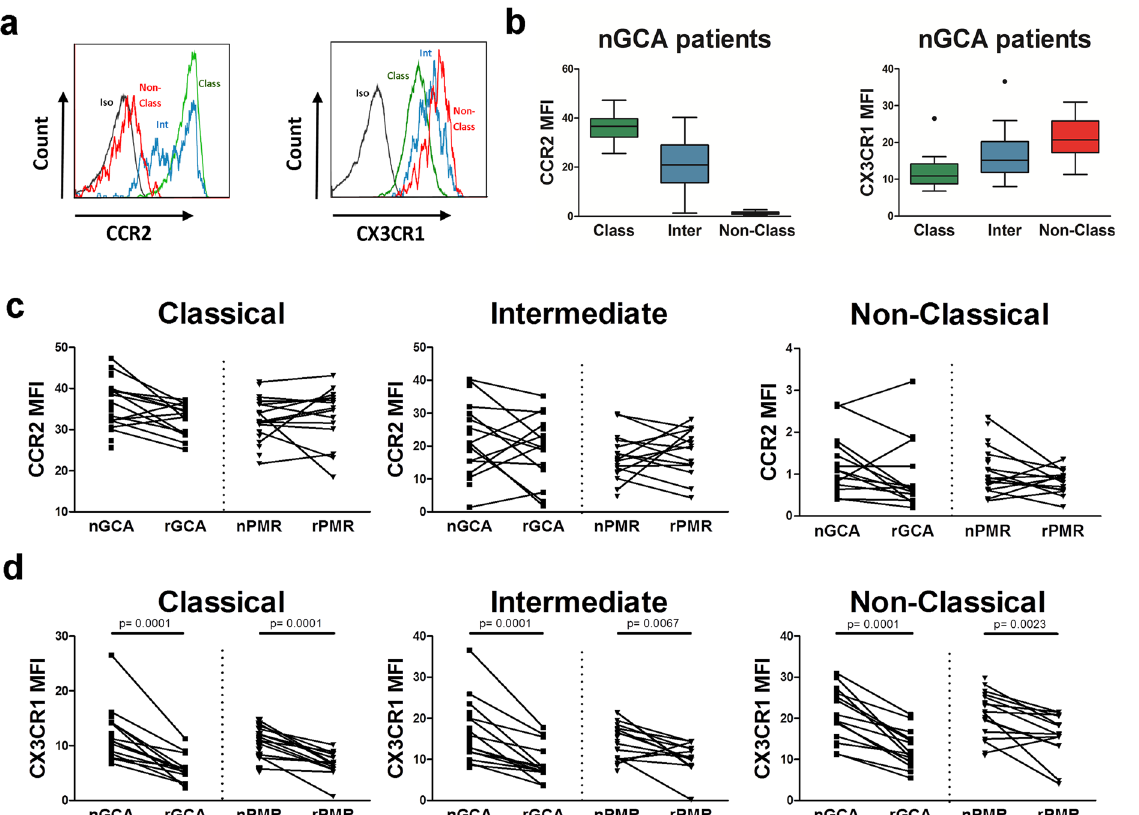
Figure 4. Expression of CCR2 and CX3CR1 by monocyte subsets in peripheral blood of GCA and PMR patients and effects of glucocorticoid treatment. ( a ) Representative flow cytometry dot plots of CCR2 and CX3CR1 by classical, intermediate and non-classical monocytes in a GCA patient. ( b ) Mean fluoresecence intensity (MFI) of CCR2 and CX3CR1 on classical (Class), intermediate (Inter) and non-classical (Non- Class) monocytes in newly diagnosed GCA patients (nGCA; n = 21). Data are expressed as Tukey box and whisker plots. The bottom and top of the box represent the first and third quartiles, and the band inside the box represents the second quartile (the median). The whiskers represent the 1.5 IQR of the lower and the upper quartiles. Outliers are plotted as dots. ( c ) Mean fluorescence intensity (MFI) of CCR2 and CX3CR1 ( d ) on classical, intermediate and non-classical monocytes in newly diagnosed GCA (nGCA; n = 21) and PMR (nPMR; n = 20) patients and in the follow-up samples of GCA (rGCA; n = 15) and PMR (rPMR; n = 14) patients in remission after 3 months of glucocorticoid treatment. Data are expressed as dot plots linking individual paired data. The Wilcoxon signed rank test was used to compare paired samples. P values are indicated in the